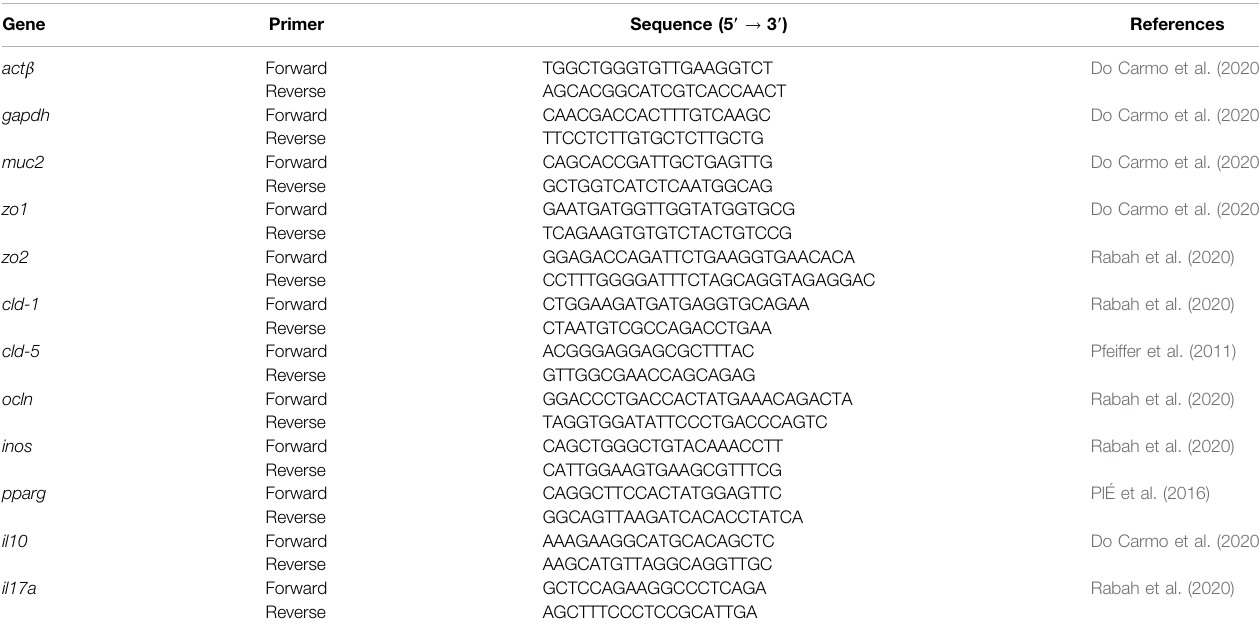
TABLE 1 | Primer list for RT-quantitative PCR